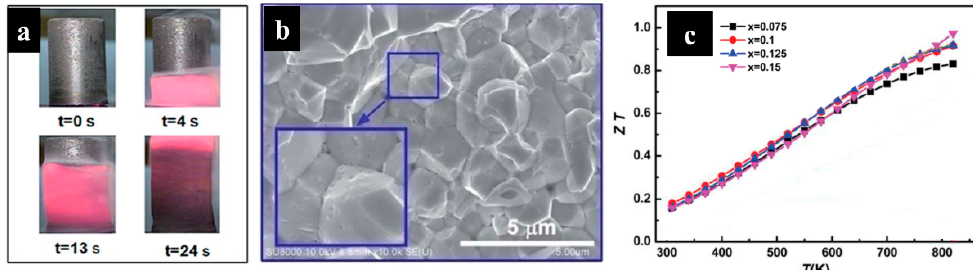
Figure 11. ( a ) Different stages of the SHS process; ( b ) the FESEM image of the bulk CoSb 3-x Te x com- pound after SHS-PAS processing; ( c ) the dimensionless figure of merit ZT of CoSb 3-x Te x compound after SHS-PAS processing [27].